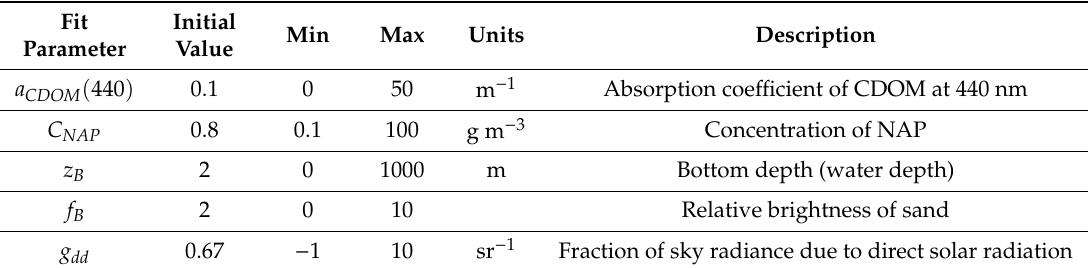
Table 1. Fit parameters of WASI and associated initial values for the shallow-water